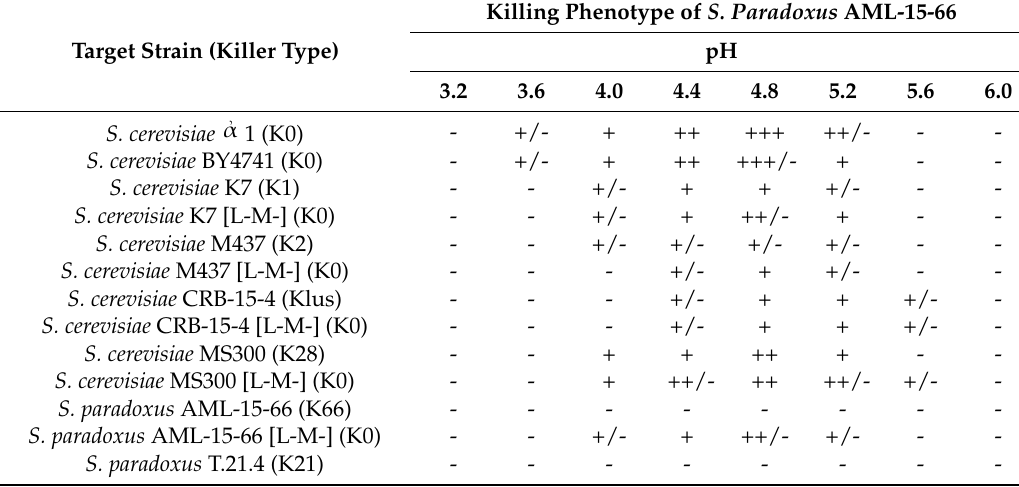
Table 1. Killing phenotype of S. paradoxus AML-15-66 strain. Diameter of zone of inhibition in mm: +++ (3–2.5), +++/- (2.5–2), ++ (2–1.5), ++/- (1.5–1), + (1–0.5), +/-